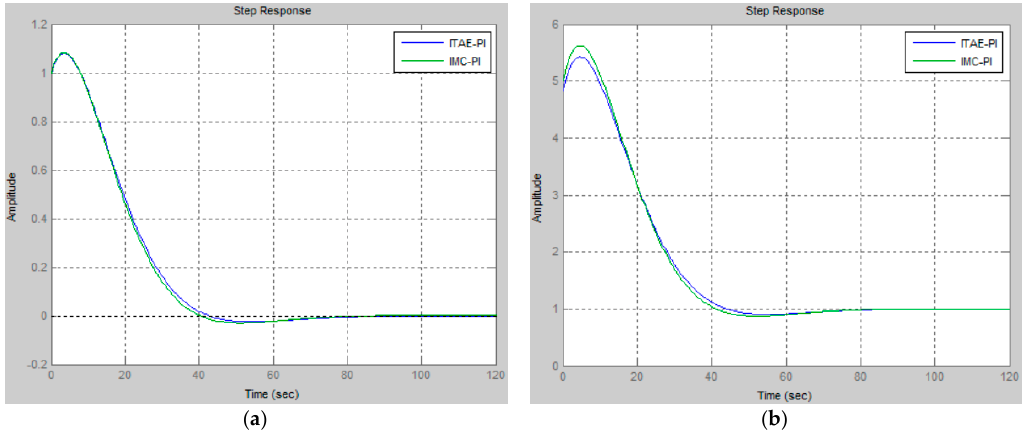
Figure 8. The sensitivity functions: ( a ) S = 1/ ( H